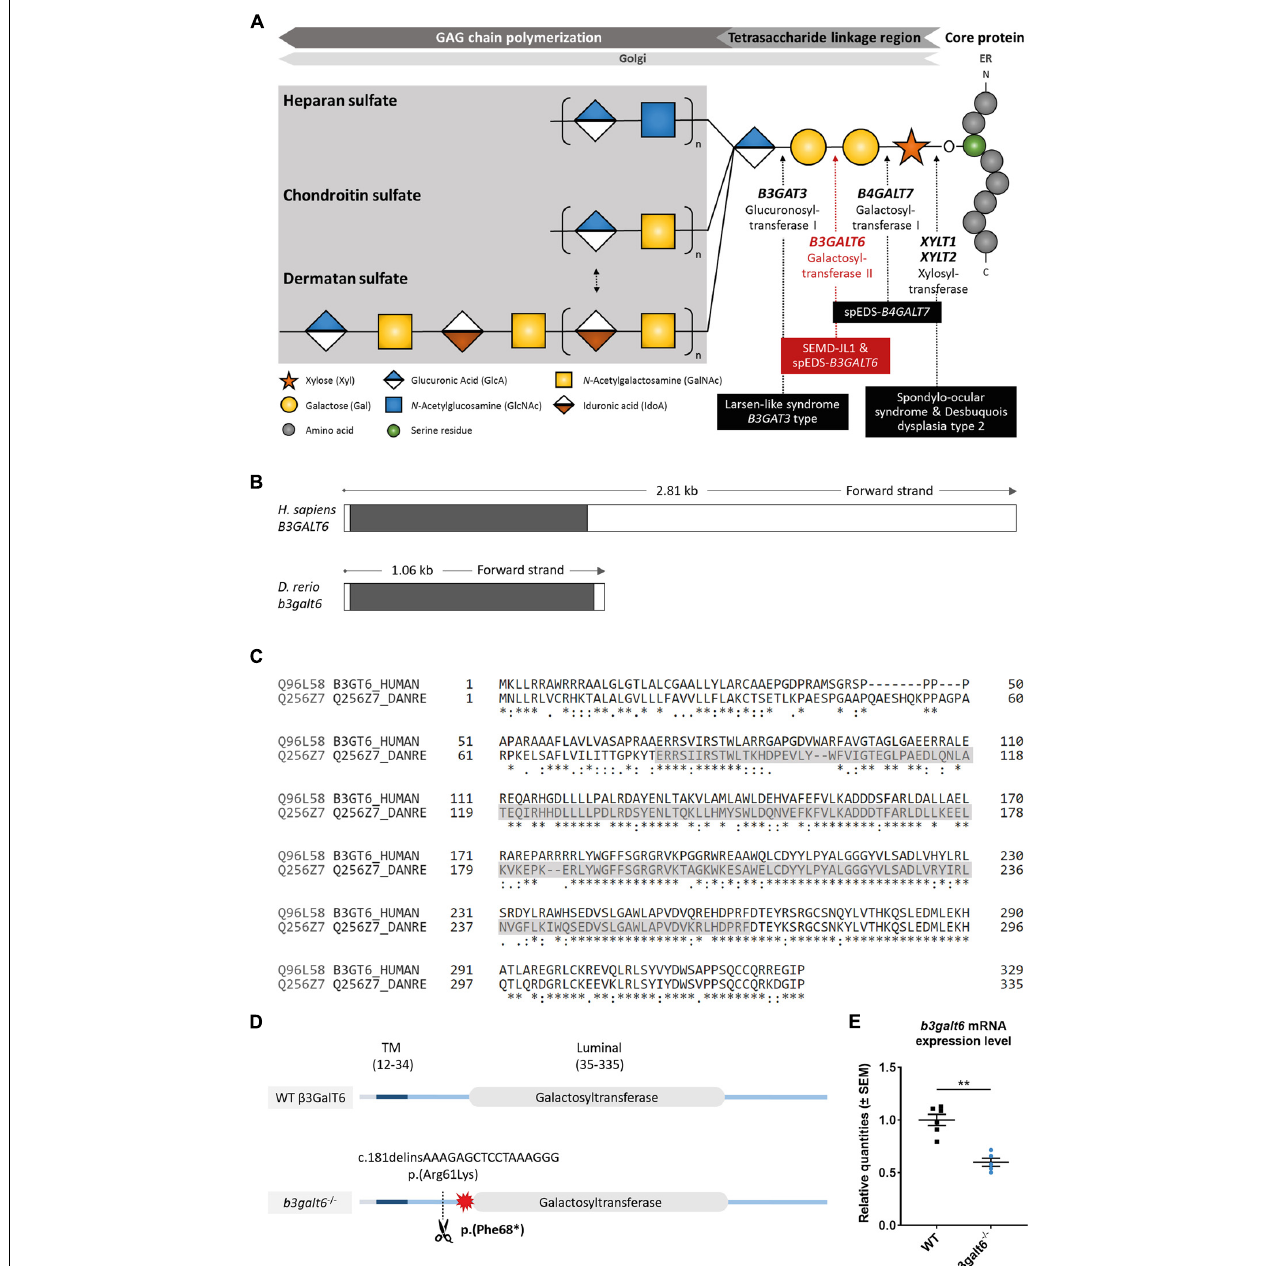
FIGURE 1 | Schematic representation of the GAG biosynthesis and the evolutionary conservation of the zebrafish and human b3galt6 / B3GALT6 gene and B3galt6/ β 3GalT6 protein. (A) Simplified schematic representation of the PG linkage and GAGs biosynthesis. PG core proteins are synthesized in the endoplasmic reticulum and undergo further modification in the Golgi apparatus. First, a tetrasaccharide linkage region is synthesized that originates from the addition of a Xyl onto a serine residue of the core protein. Subsequent addition of two Gals and one GlcA residues completes this process. Depending on the addition of GlcNAc or GalNAc to the terminal GlcA residue of the linkage region, HS or CS/DS PGs will be formed, respectively. The elongation of the GAG chain continues by repeated addition of uronic acid and amino sugar residues. The GAG chain is then further modified by epimerization and sulfation (not shown). The main genes encoding for the enzymes involved in the linkage region biosynthesis are indicated in bold and biallelic mutations in these genes result in different linkeropathies. Disorders resulting from deficiency of the enzymes are indicated in black boxes. The deficient enzyme ( β 3GalT6) and the related disorder studied here are depicted in red (e.g., spEDS- B3GALT6 and SEMD-JL1). (B) Schematic representation of the genomic structure of the H. sapiens B3GALT6 (NM_080605.4) and D. rerio b3galt6 (NM_001045225.1) genes. The white and black boxes represent the untranslated regions and the single B3GALT6 / b3galt6 exon, respectively. The zebrafish